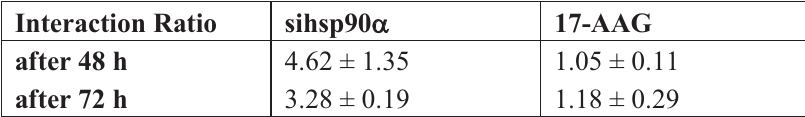
Table 1. sihsp90 (cid:2) synergizes with 17-AAG enhancing chemosensitivity in U87-MG. The efficacy of the concurrent assay with 17-AAG and sihsp90 (cid:2) was assessed using interaction ratios generated by a ratio of the observed growth inhibition following treatment with both compounds versus growth inhibition using either compound independently. The